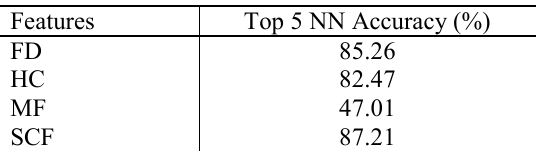
Table 4. Top 5 Nearest Neighbor (NN) accuracy is reported on MPEG dataset for all the